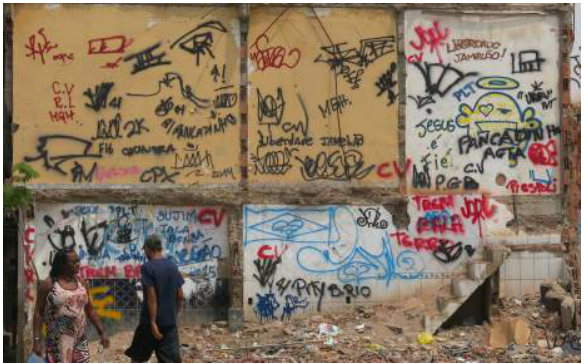
Figure 4. CV tags on home exteriors, Manguinhos,